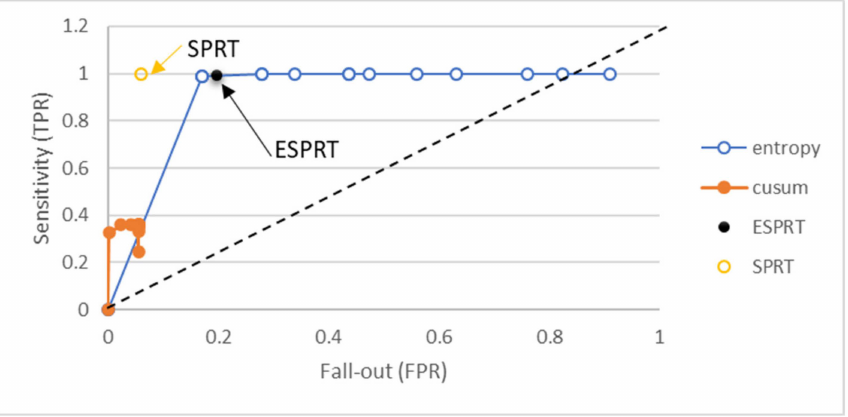
Figure 6. Sensitivity vs. fall-out for different detection methods for the Friday_1998